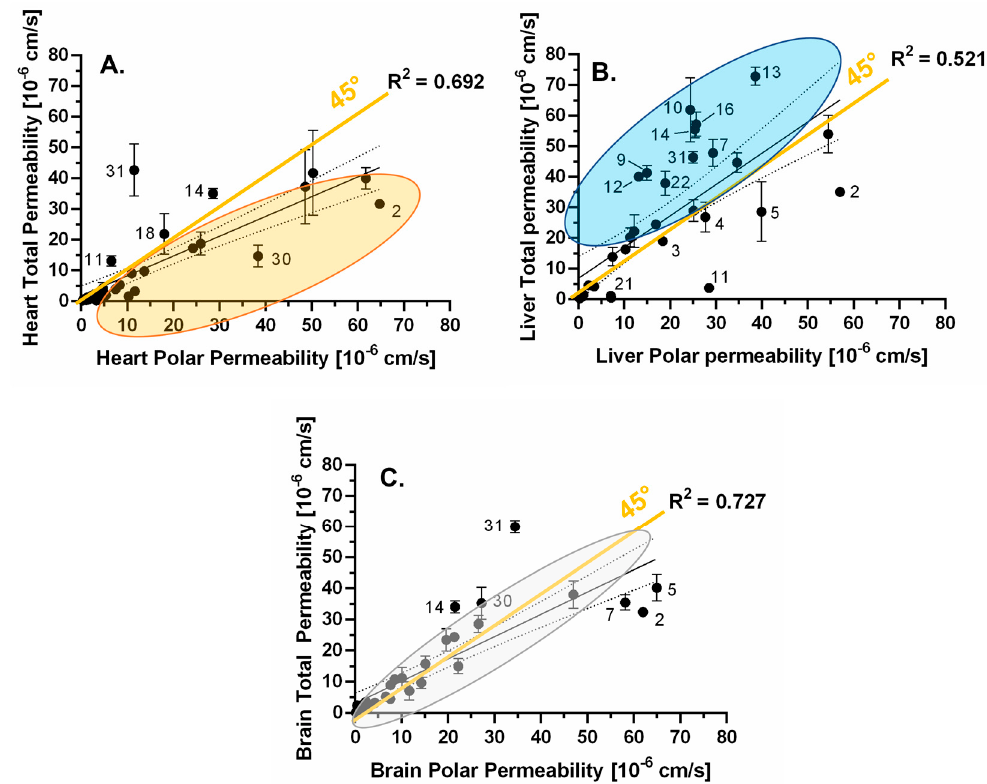
Figure 10 . Linear regression between total and polar permeability values (mean, n = 3) for each tissue: ( A ) heart, ( B ) liver, and ( C ) brain. The compounds are numbered as in Figure 2D.